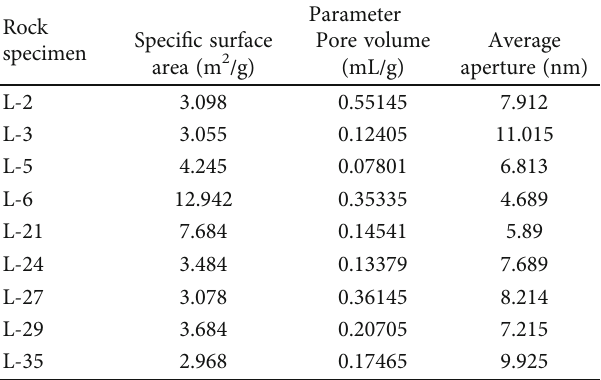
Table 2: Pore structure parameters of the shale samples.